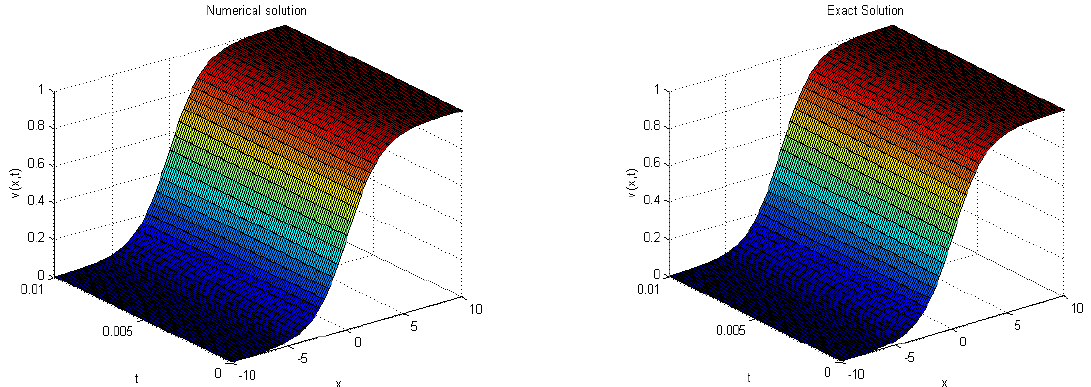
Figure 2. Analogize of solution for Example 1 for 𝑡 ≤